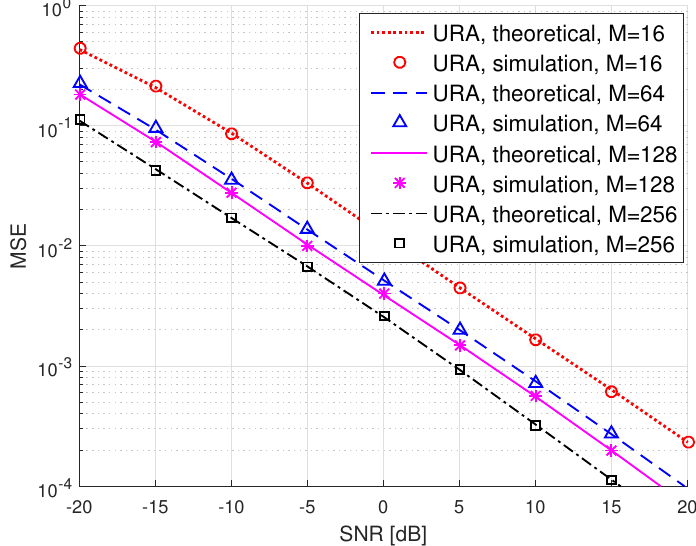
Figure 5. MSE vs. SNR in dB for the URA topology, U = 10 UEs, α A ( AS ) = 5, with different numbers of base station